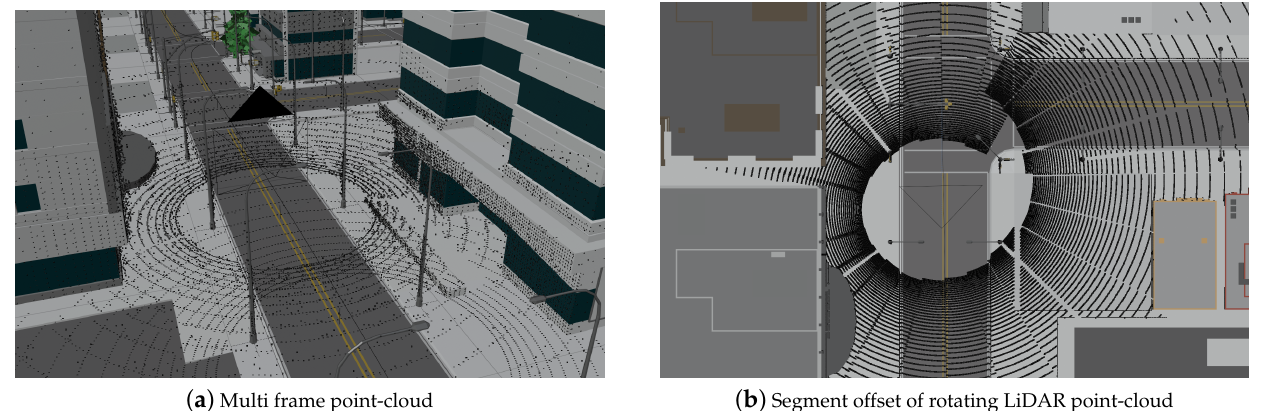
Figure 13. ( a ) A simulated 360°-LiDAR sensor travels along a street of a 3D city model (City model from to [76]), generating multiple point-cloud frames. ( b ) The top view shows the spiral shape of a point-cloud for a single frame which is characteristic for moving, rotating LiDAR sensors.